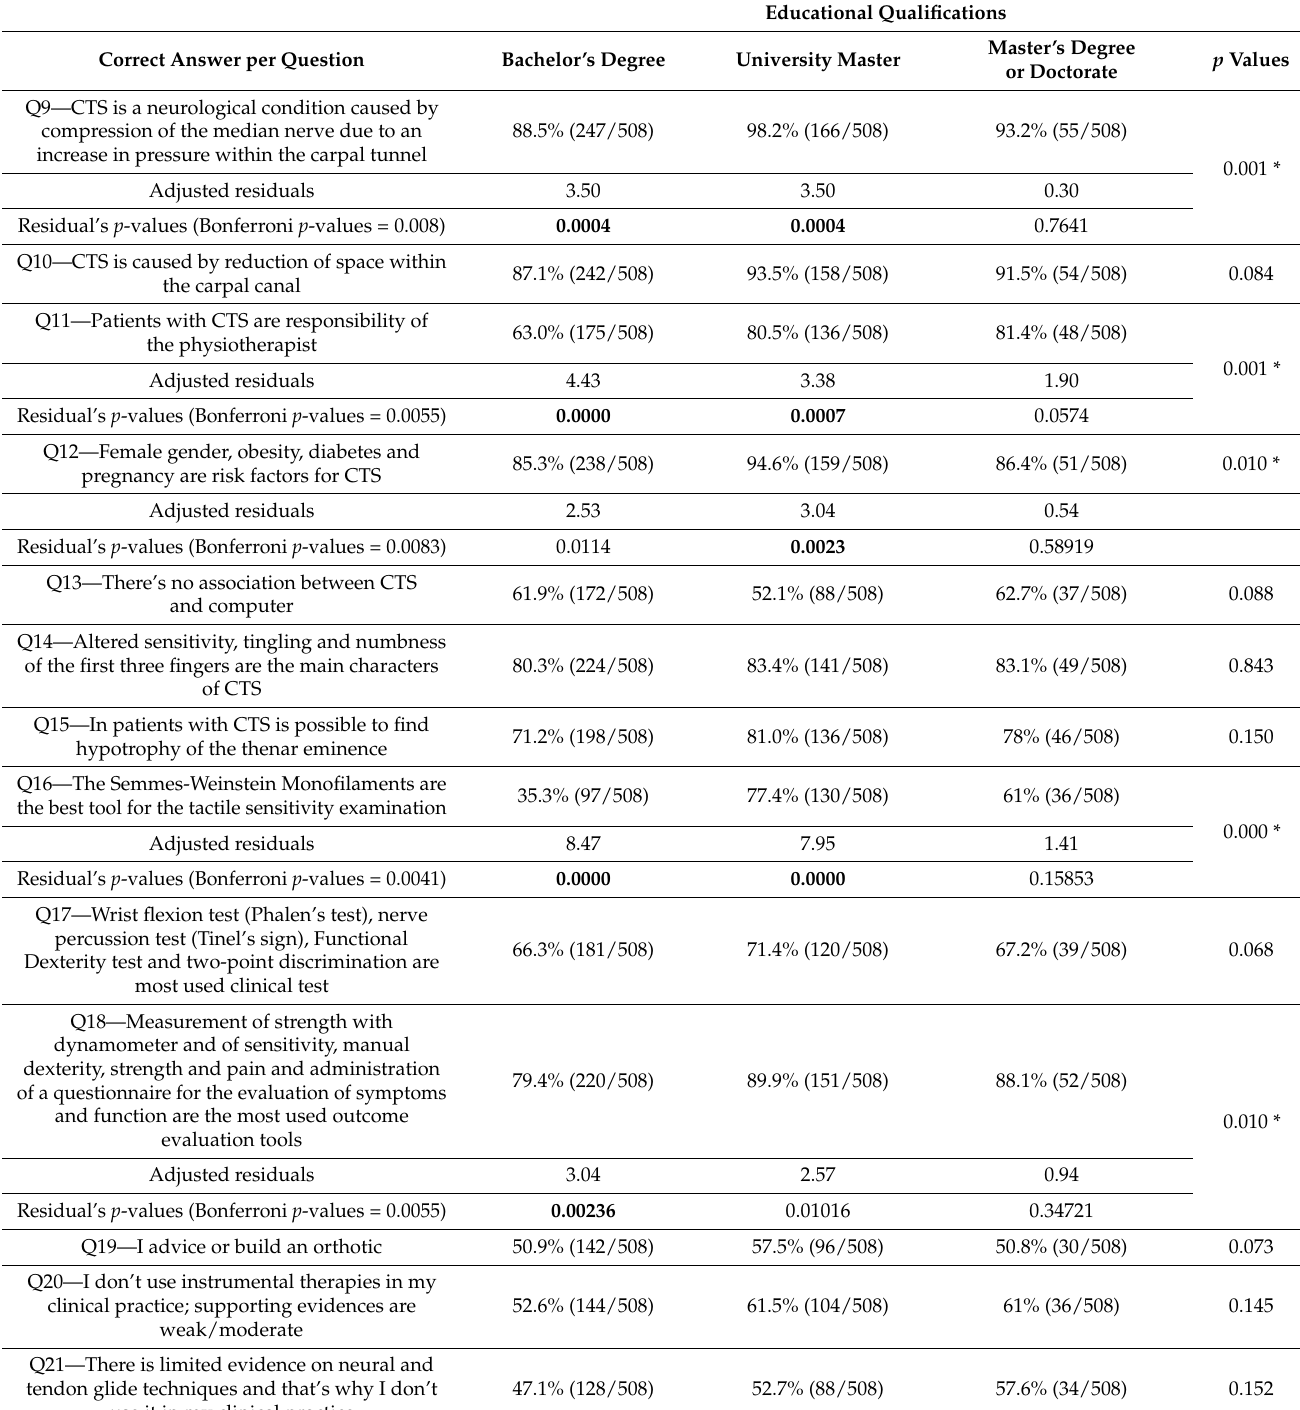
Table 2. Inferences between correct answers and the respondents’ educational